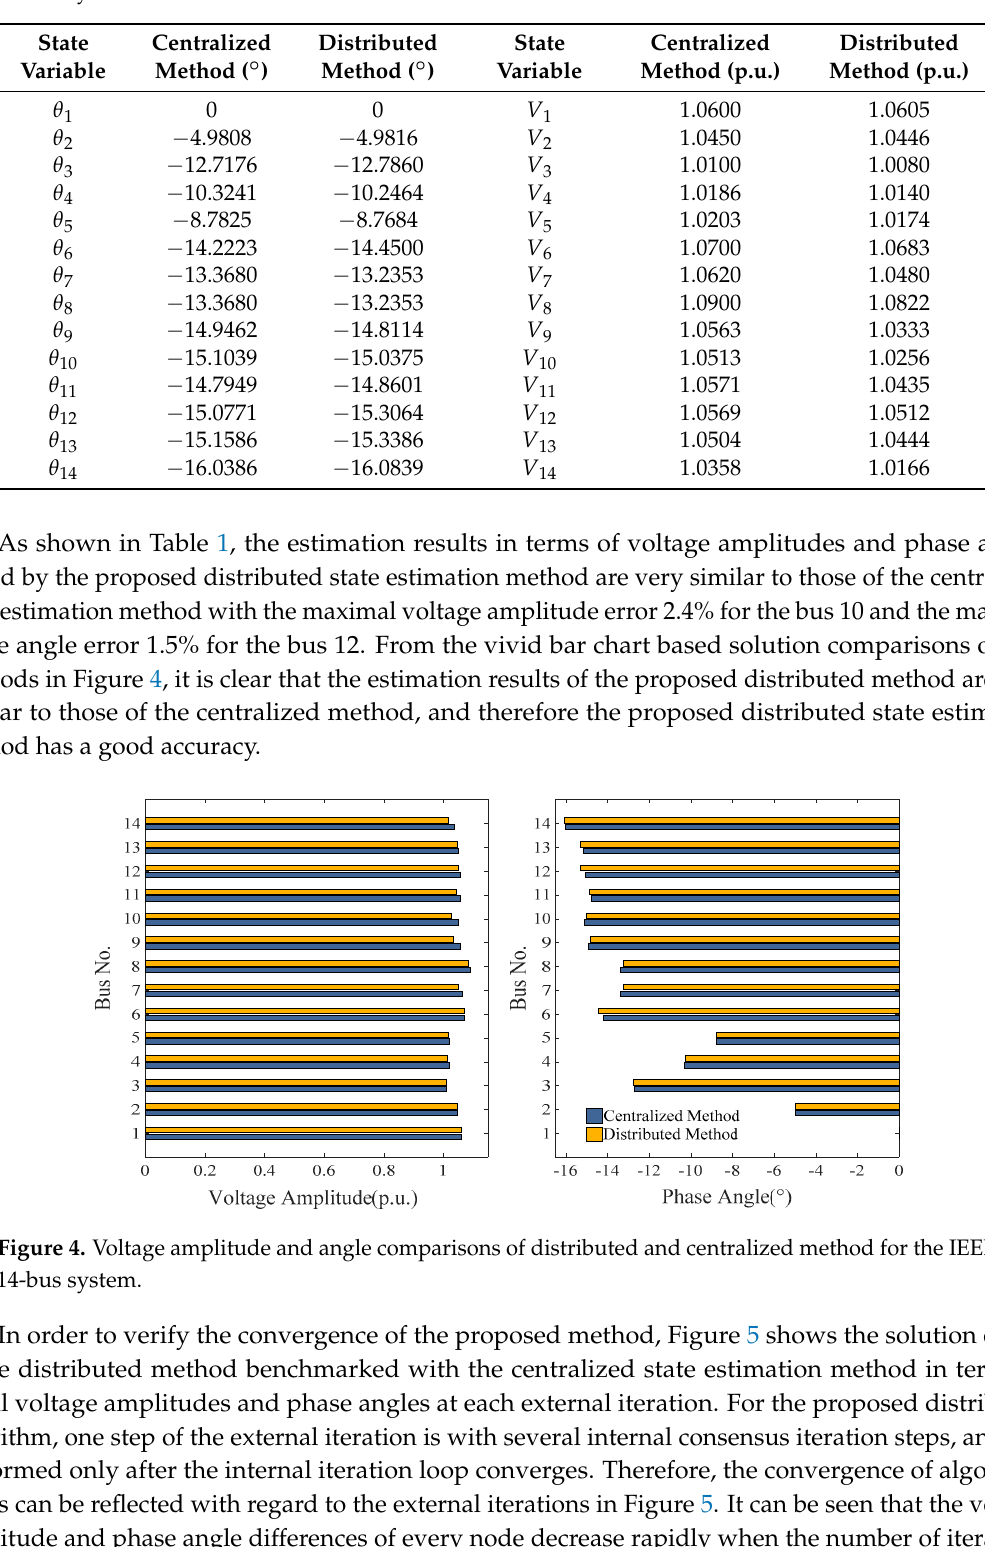
Table 1. Solution comparisons of distributed and centralized state estimation method for the IEEE 14-bus system.